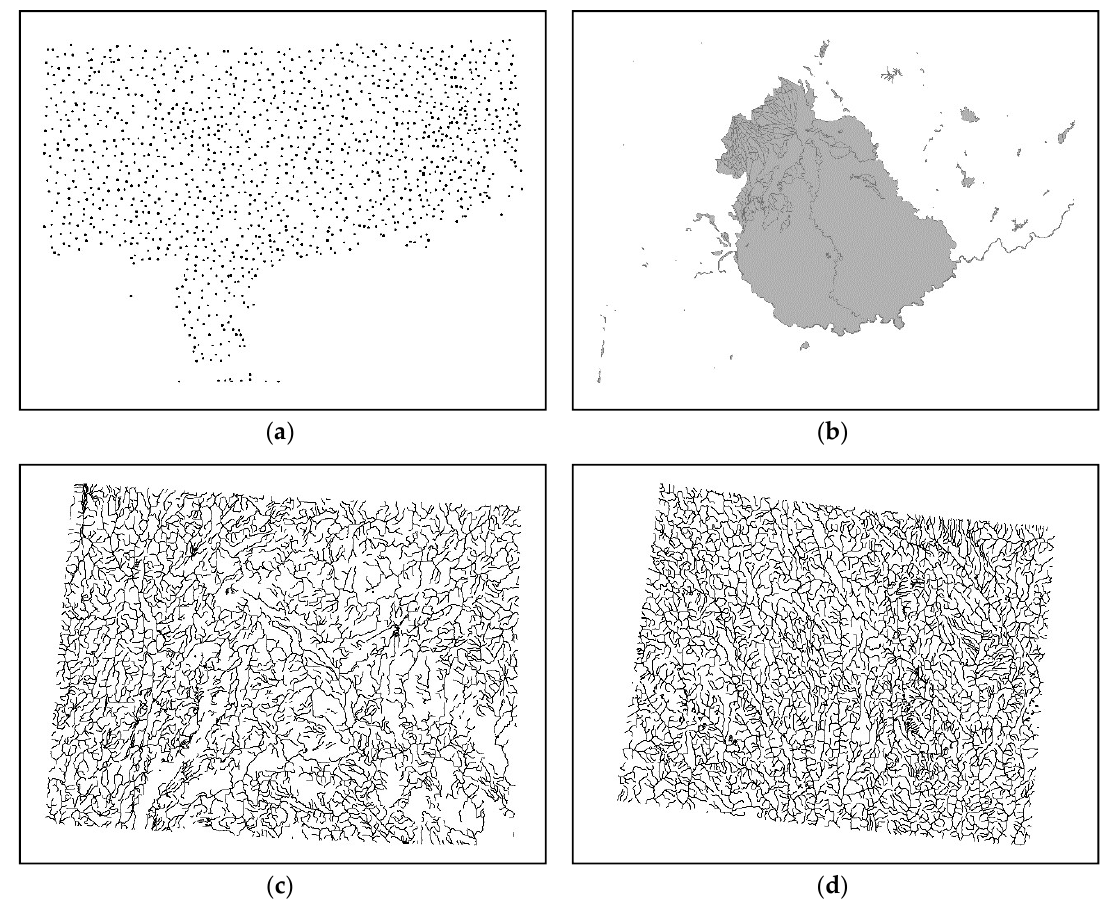
Figure 7. Examples of experimental data. ( a ) Digital vector geographic maps organized as points; ( b ) digital vector geographic maps organized as polygons; ( c ) and ( d ) digital vector geographic maps organized as polylines.